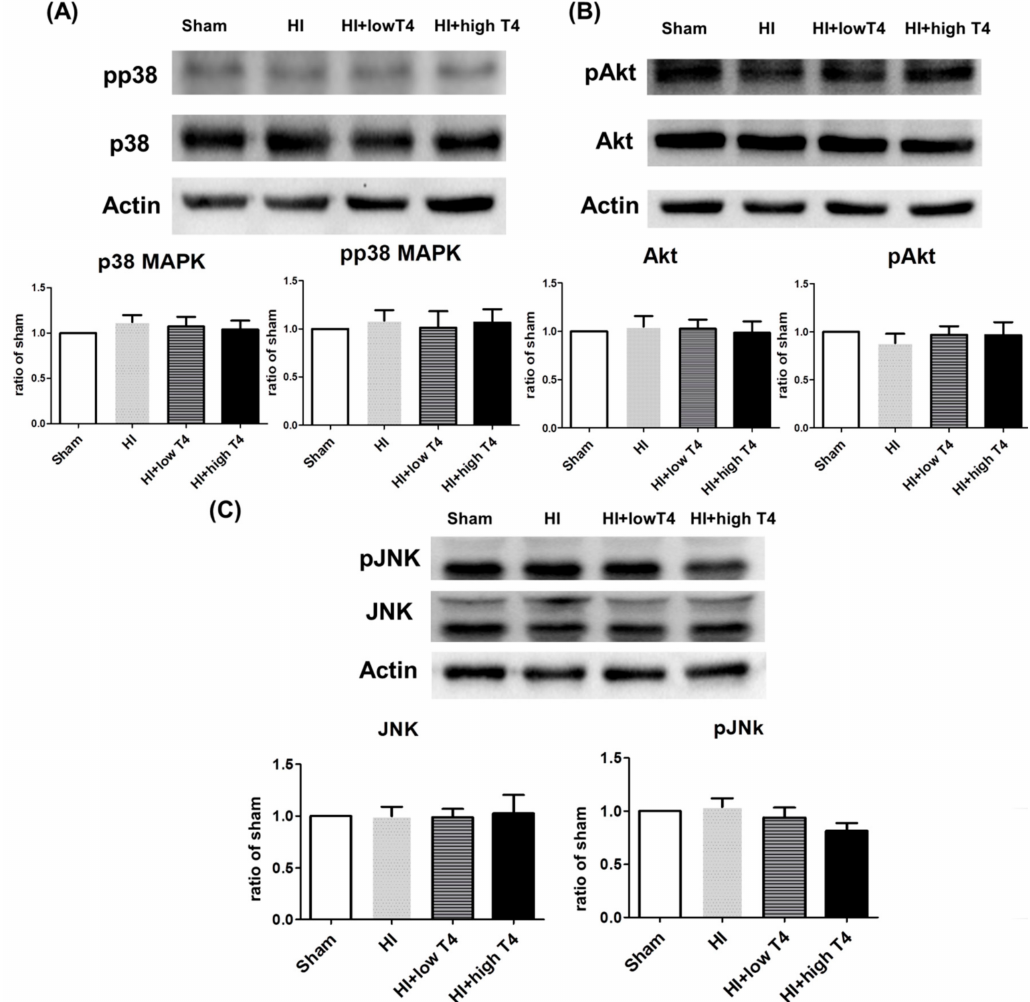
Figure 4. Effects of HI insult and T4 treatment on p38 mitogen-activated protein kinases (MAPK), AKT, and JNK signaling pathways. HI and HI+T4 had no effect on the concentrations of ( A ) total p38 and phosphorylated p38 MAPK, ( B ) total Akt and phosphorylated Akt, or ( C ) total JNK and phosphorylated